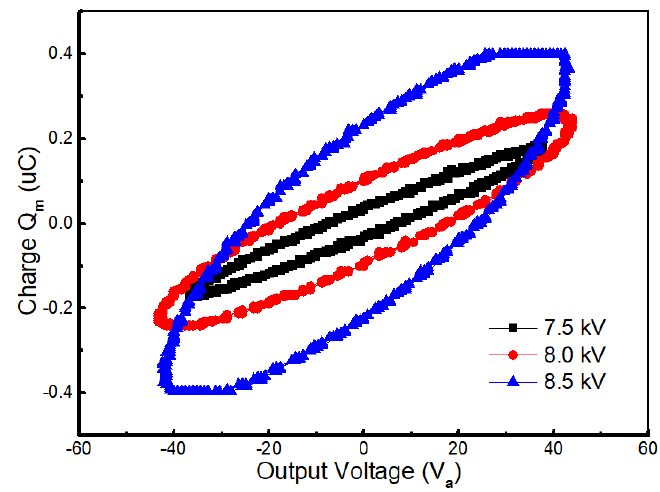
Figure 9. Waveforms of V-Q Lissajous at applied voltage V = 7.5 kV, 8.0 kV and 8.5 kV.